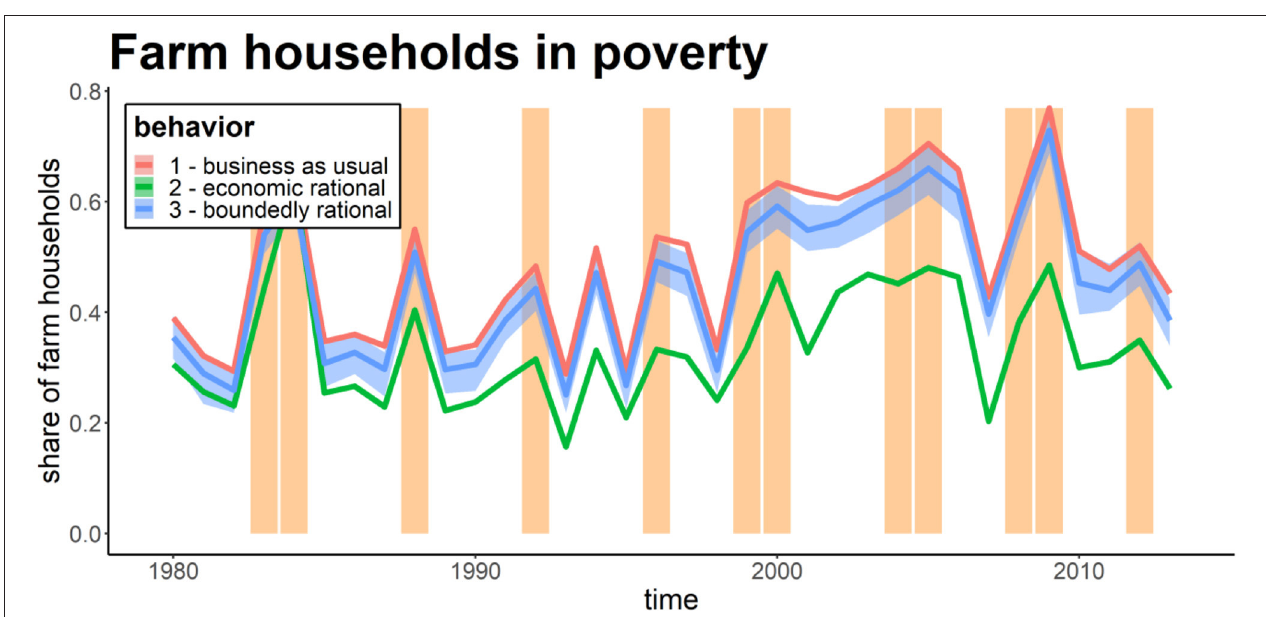
FIGURE 7 | Share of households in poverty. Variability over time is visualized for three behavioral scenarios: economic rational (EUT), bounded rational (PMT), and no adaptation decisions (BAU). Drought years (SPEI value in crop season < − 1) are visualized as vertical orange bars. The shaded blue area shows the variance among 50 bounded rational model runs, a result of the variety in weights of the PMT